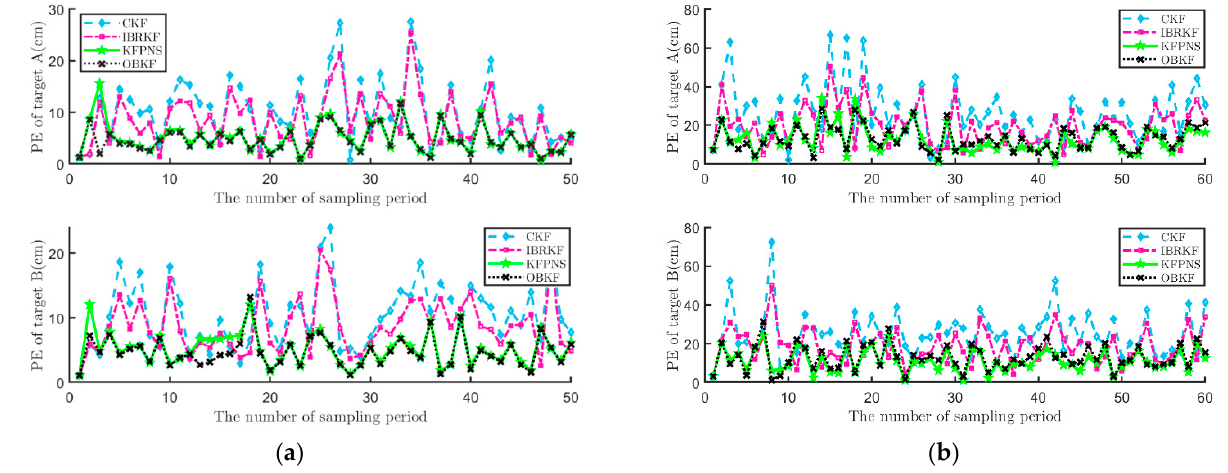
Figure 10. The PE of each filter in two specific scenes. ( a ) Comparison of PE of various Kalman filters in an indoor scene. ( b ) Comparison of PE of various Kalman filters in an outdoor scene.